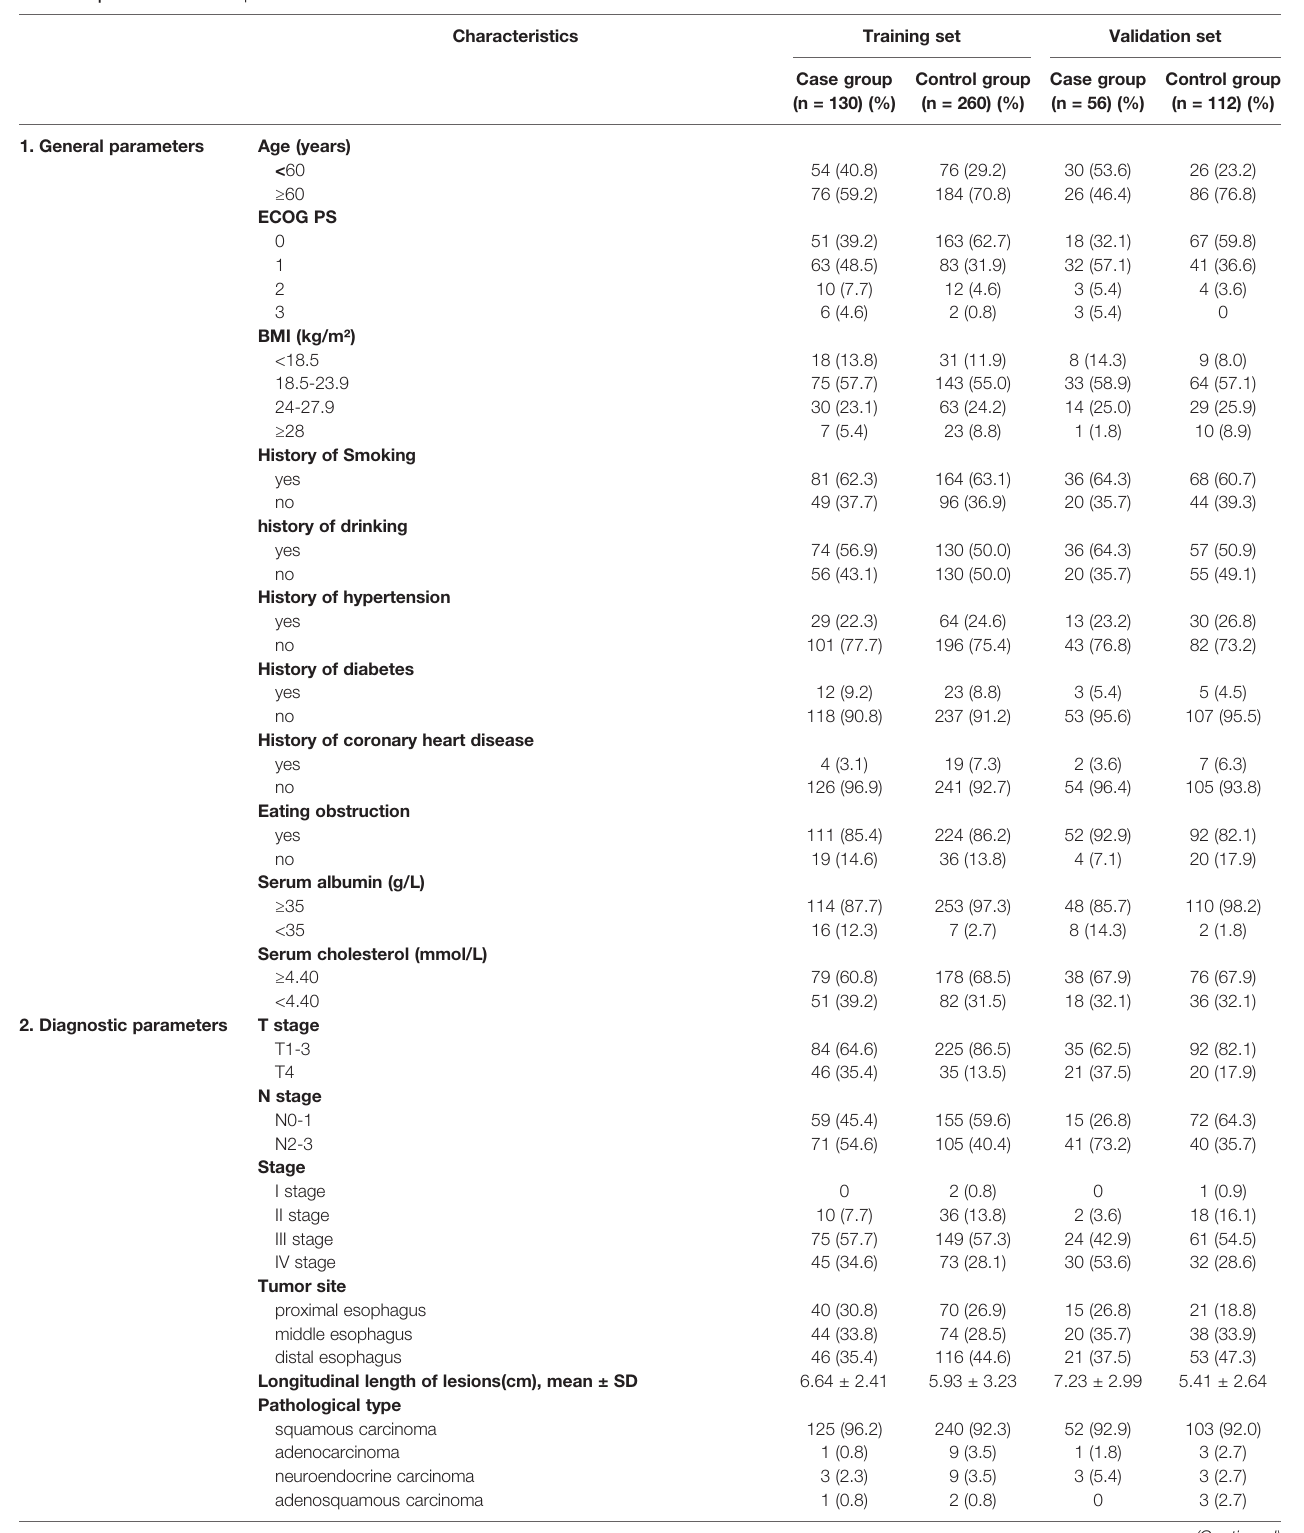
TABLE 1 | Characteristics of